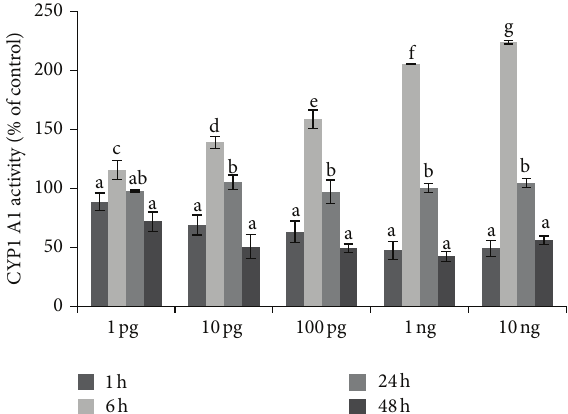
Figure 1: Time- and dose-dependent action of Halowax 1051 on CYP1 A1 activity showed as a percentage of control. Cocultures of granulose and theca cells were exposed to 1, 10, and 100pg/mL and 1 or 10ng/mL of Halowax 1051. Each treatment was repeated three times ( 𝑛 = 3 ). Statistically significant differences between points in graph are indicated with different letters; the same letters indicating no significant differences, with a < b < c < d < e < f < g.